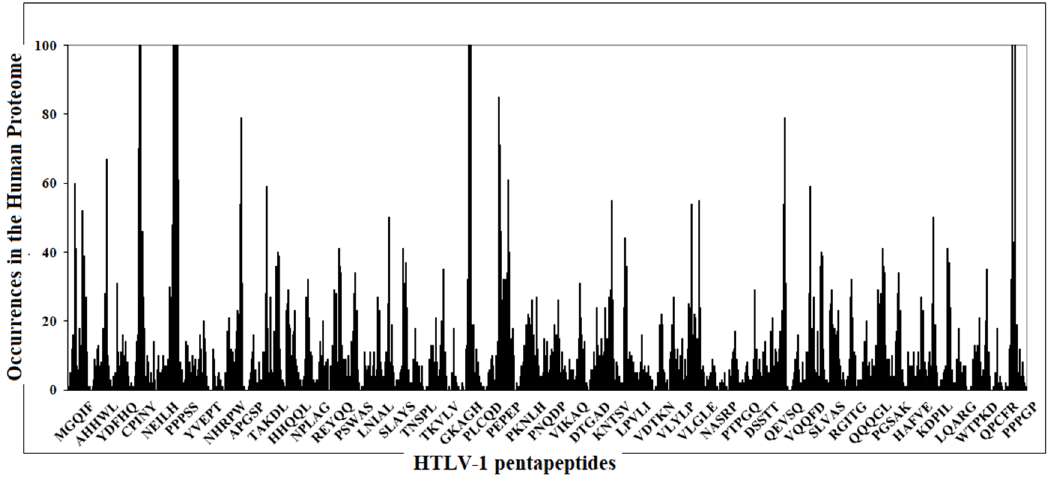
Figure 1. Matching profile of the HTLV-1 aa sequence to the human proteome at the pentapeptide level. As a second step in our investigation, we searched among pentapeptides absent in the human sequences and eventually selected unique consecutive viral pentapeptides overlapping each other by four residues. The results are reported in Table 1, showing that HTLV-1 has 15 peptide stretches consisting of at least 3 pentapeptides overlapping each other by 4 residues, distributed among the viral proteins Gag polyprotein, Gag-Pro-Pol polyprotein, Envelope glycoprotein gp62, and Protein Tax-1. Table 1. Peptides that are ≥ 7mer long and consist of overlapping minimal 5-mer immune determinants unique to HTLV-1 and absent in the human proteome.